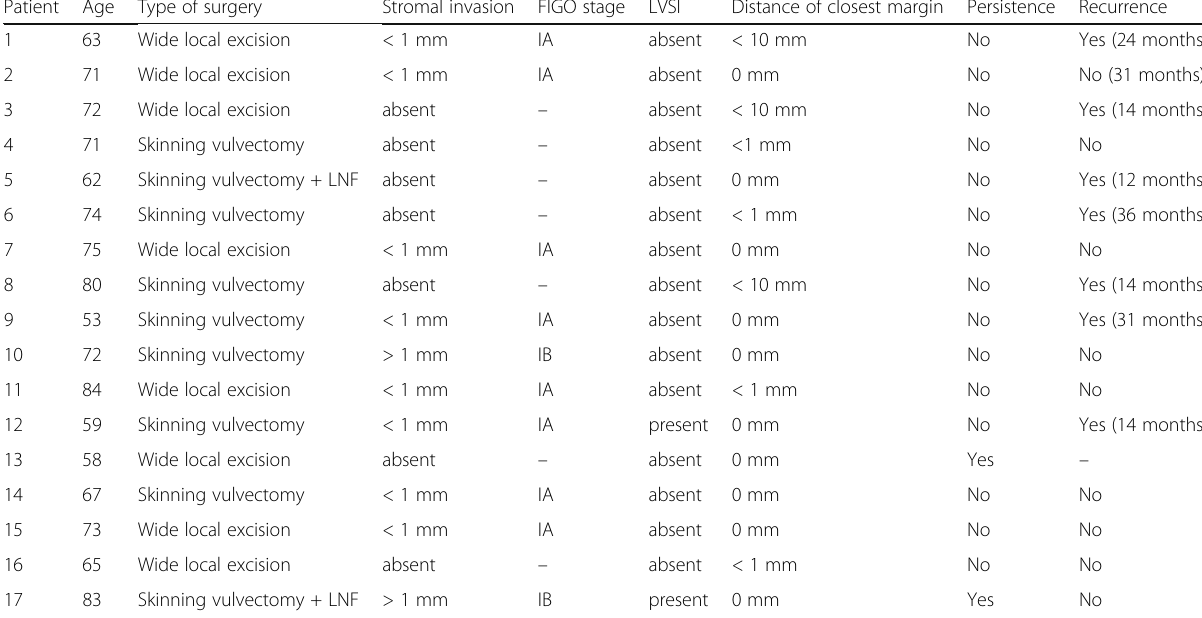
Table 1 Clinical and pathological characteristics of women of the study cohort Patient Age Type of surgery Stromal invasion FIGO stage LVSI